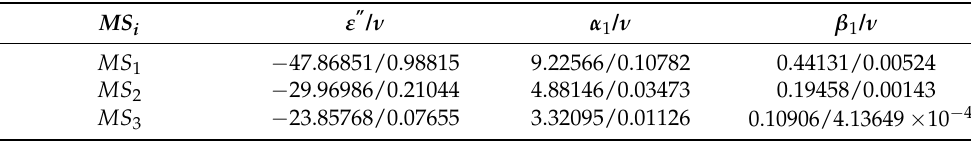
Table 8. The values of ε (cid:48)(cid:48) , α 1 and β 1 for